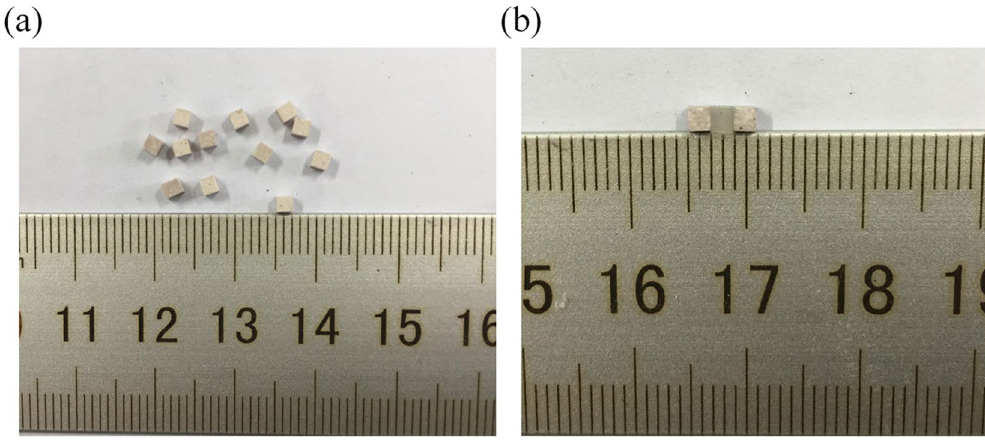
Figure 2. ( a ) The dielectric ceramic cubes with dimensions of 2 mm × 2 mm × 2 mm. ( b ) The fabricated force sensor composed of two dielectric cubes and a silicone rubber